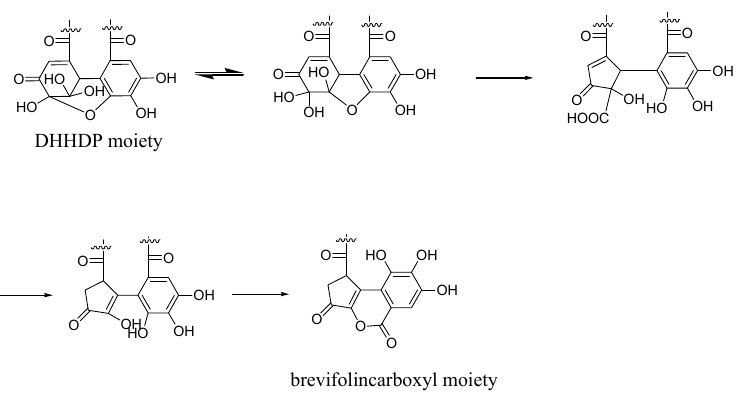
Figure 6. Suggested biosynthesis route of brevifolincarboxyl moiety from the DHHDP moiety.